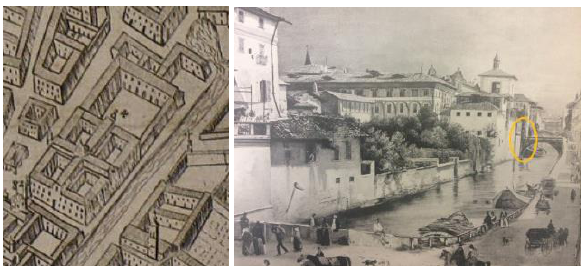
Fig. 2. “La Gran Città di Milano”, GioBatta Bonacina, 1699 (left); a 19 th century painting of the canal adjacent to the hospital, the yellow circle indicates the entry from the canal